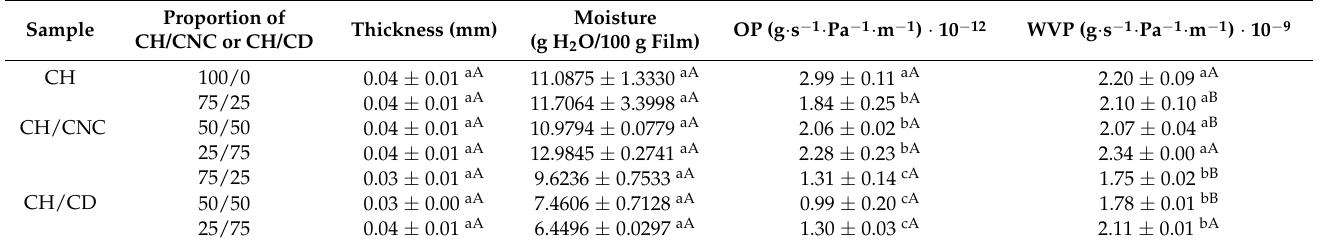
Table 2. Thickness, moisture and barrier properties of CH, CH/CNC and CH/CD final formed edible